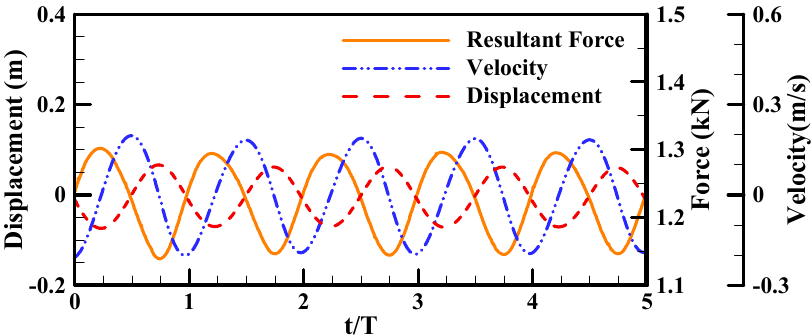
Figure 11. Phase relationship among resultant force, velocity, and displacement of the buoy.